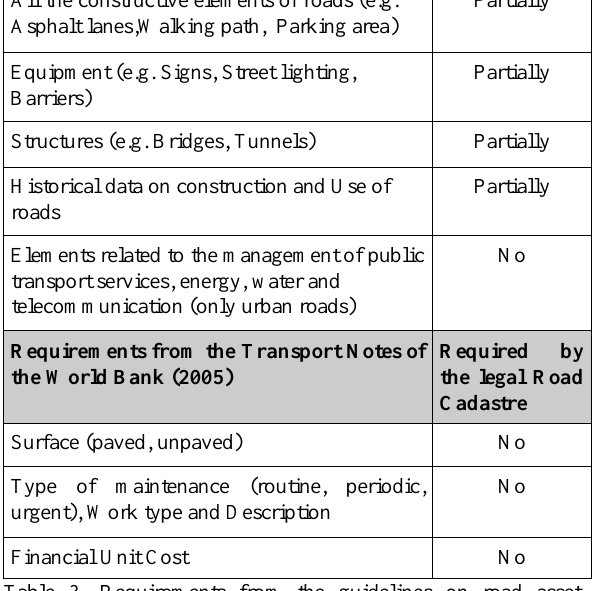
Table 3. Requirements from the guidelines on road asset